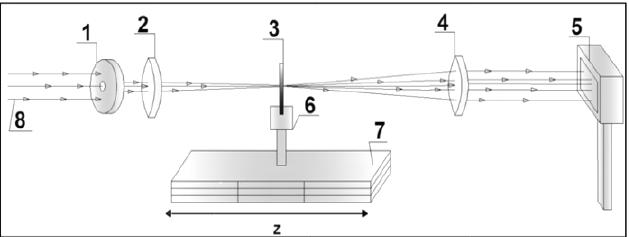
Fig. 2. Schematic diagram of the Z scan method: 1 – aperture; 2,4 – lenses; 3 – test sample; 4 - collecting lens; 5 – power meter;6 – holder; 7 – positioning